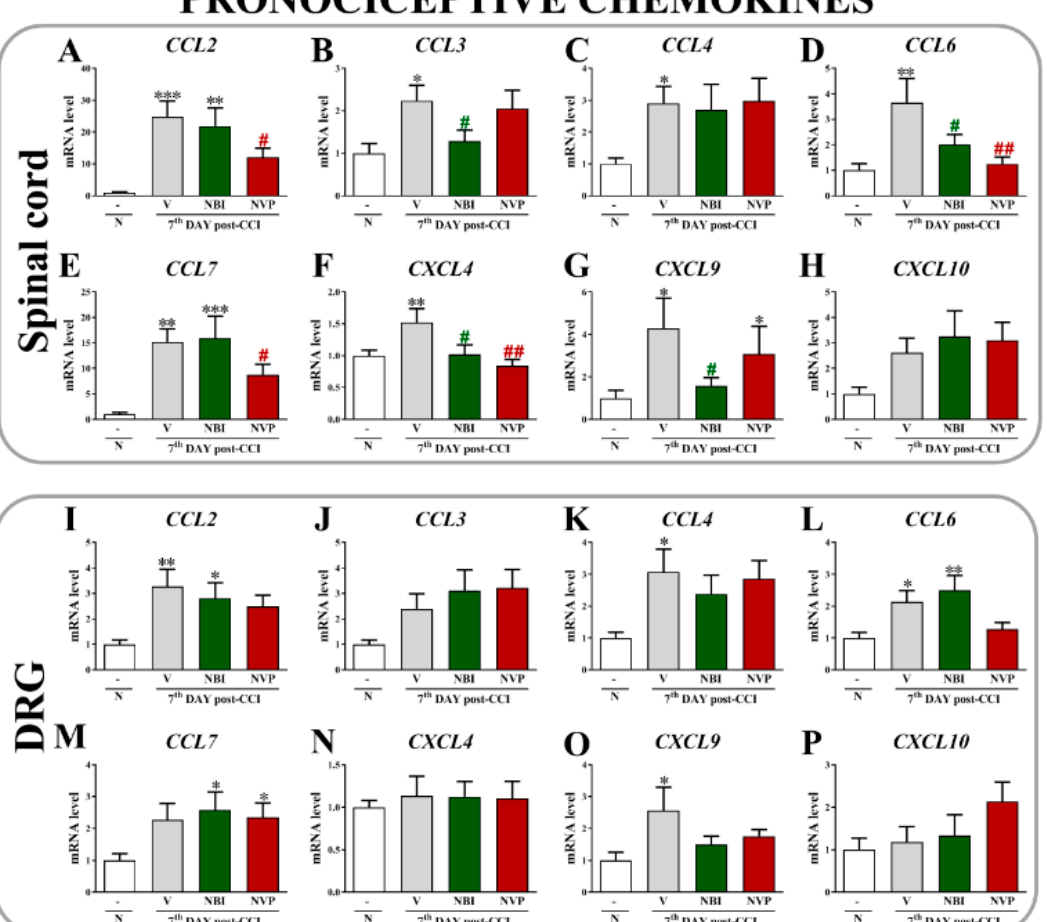
Figure 5. Comparison of the effects of repeated intrathecal ( i.t .) administration of (±)-NBI 74330 and NVP CXCR2 20 (10 µg/5 µL; each) on the mRNA ( A – P ) levels of select chemokines (CCL2, CCL3, CCL4, CCL6, CCL7, CXCL4, CXCL9, and CXCL10) in the spinal cord ( A – H ) and DRG ( I – P ) on the 7th day after chronic constriction injury in rats. The RT-qPCR data are presented as the means ± SEM (4–9 rats per group). The results were evaluated using one-way ANOVA followed by Bonferroni’s test. * p < 0.05, ** p < 0.01, and *** p < 0.001 for the comparison of naive animals with all groups. # p < 0.05 and ## p < 0.01 for the comparison of vehicle-treated animals with all groups. Abbreviations: naive, N; vehicle, V; (±)-NBI 74330, NBI; NVP CXCR2 20, NVP.